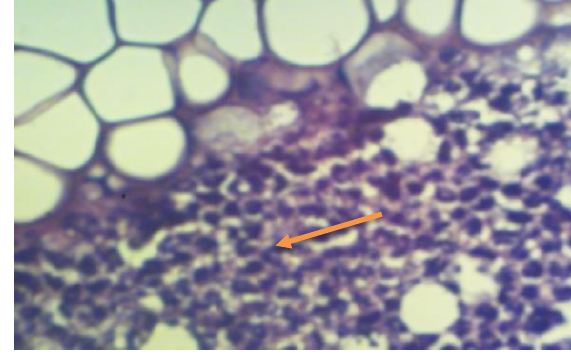
Figure, 5: Histological section show inflammation cell aggregation around blood vessel of external ear in other section hyper cellularity of fibrin network deposion in monolayer cavity of temporal bone. H &E stain 40X.